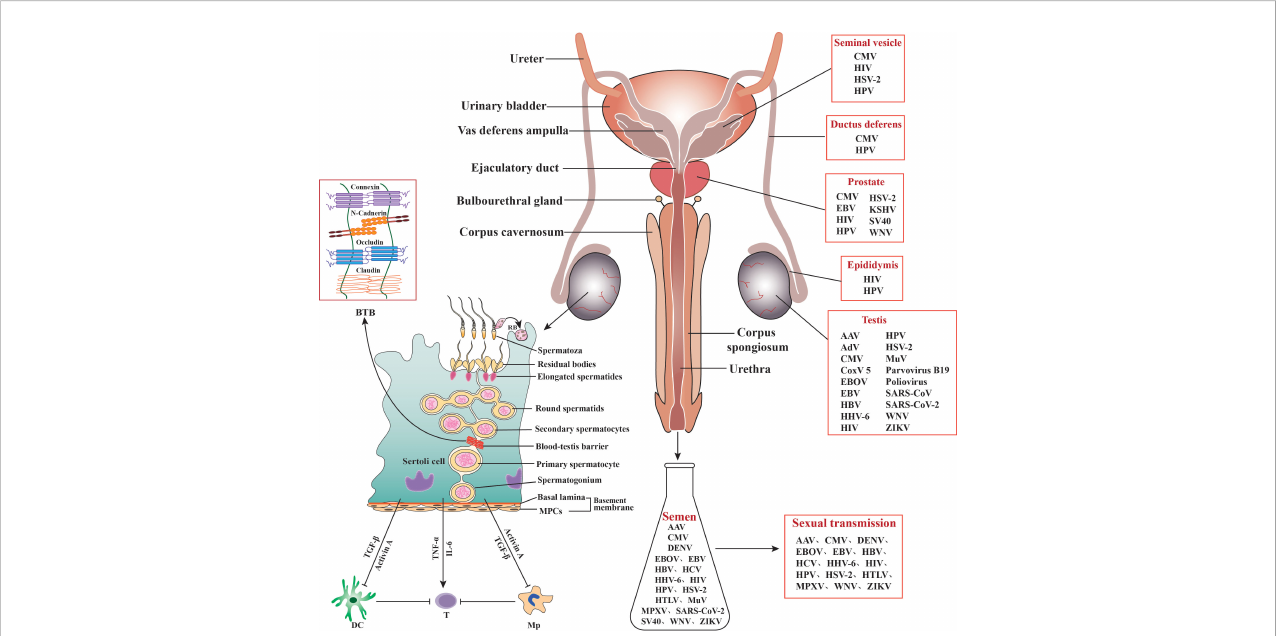
FIGURE 1 Role of Sertoli cells (SCs) in regulating testicular immunity and virus distribution in the male reproductive system (MRS). Middle panels: The MRS is composed of various organs, including testes, epididymides, prostates, seminal vesicles, and bulbourethral gland. These organs are connected by genital ducts, including ductus deferens, vas deferens ampulla, ejaculatory duct, and urethra. Left panels: The blood-testis barrier (BTB) is formed by adjacent SCs with several cellular junction proteins and separates the majority of germ cells within the adluminal compartments behind the BTB from immune cells in the interstitial spaces. SCs secrete activin A and transforming growth factor b (TGF − b ) that inhibit immune responses of dendritic cells (DCs) and macrophages (Mp), thereby inhibiting effective T cell activation. SCs may also produce in fl ammatory factors, such as tumor necrosis factor a (TNF − a ) and interleukin 6 (IL − 6), in response to antigen challenges, which can activate T cells and induce in fl ammatory conditions. MPCs, myoid peritubular cells; RB, residual body; ⟂ , inhibition; ! , activation. Right panels: A broad spectrum of viruses has been detected in the MRS and in semen, and some of the seminal viruses can be sexually transmitted. AAV, Adeno-associated virus; AdV, Adenovirus; CMV, Cytomegalovirus; CoxV 5, Coxsackie virus 5; DENV, Dengue virus; EBV, Epstein-Barr virus; EBOV, Ebola virus; HBV, Hepatitis B virus; HCV, Hepatitis C virus; HHV-6, Human herpes virus 6; HIV, human immunode fi ciency virus; HPV, human papillomavirus; HSV, Herpes simplex virus; HTLV, Human T lymphotropic virus; KSHV, Kaposi sarcoma-associated herpes virus; MuV, mumps virus; MPXV, Monkeypox virus. SARS-CoV, severe acute respiratory syndrome associated-coronavirus; SV40, Simian virus 40; WNV, West-Nile virus; ZIKV, Zika